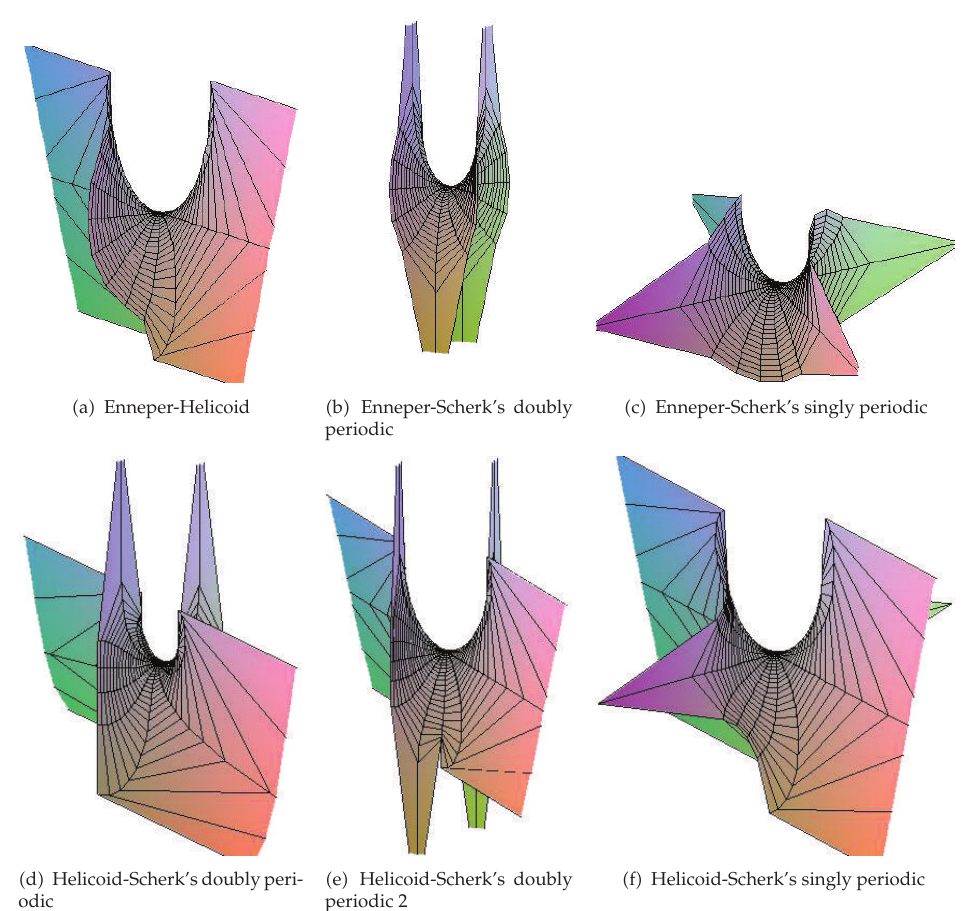
Figure 3: Various combinations of minimal